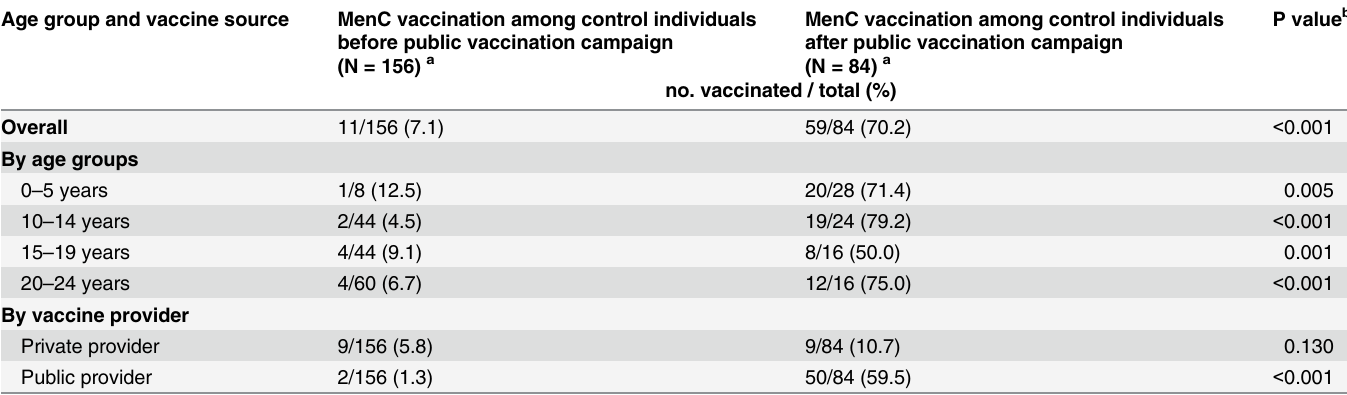
Table 3. MenC vaccination status among control individuals before and after public MenC vaccination, according to age group and MenC vaccine provider. Age group and vaccine source MenC vaccination among control individuals before public vaccination